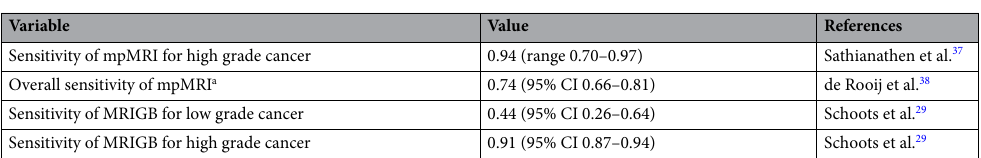
Table 1. Sensitivity values for the MRI pathway used in the model. mpMRI multi parametric magnetic resonance imaging, MRIGB magnetic resonance imaging-guided biopsy. a Used as a sensitivity of mpMRI for low grade cancer in our